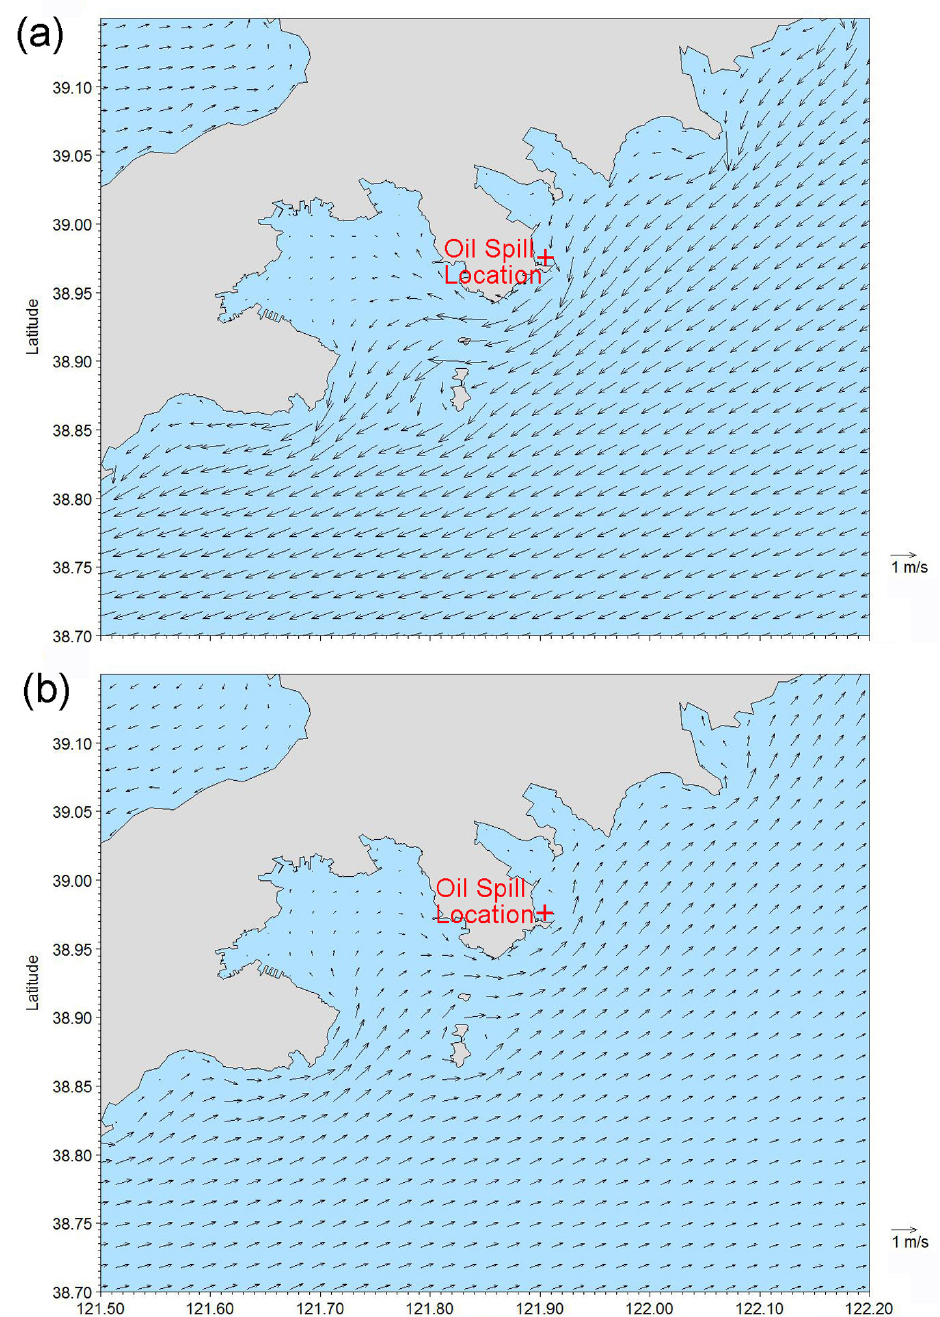
Figure 3. Tidal currents near Dalian New Port oil spill site during maximum ( a ) flood and ( b ) ebb. Arrow length represents flow intensity, and arrow direction means current direction.